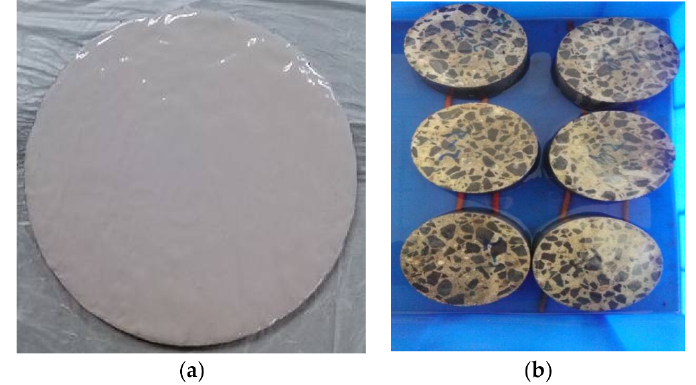
Figure 4. Test for water uptake of the concrete sample coated with the geopolymer coating. ( a )